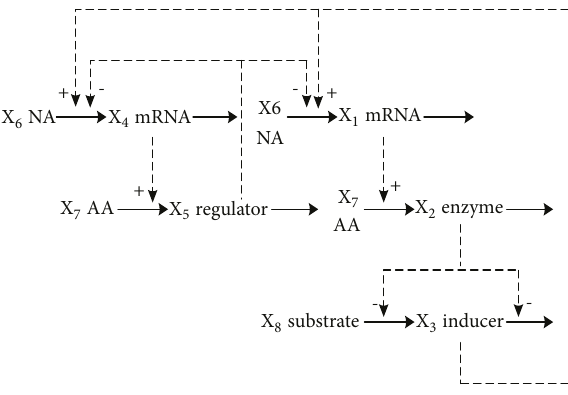
Figure 7: Small scale genetic networks